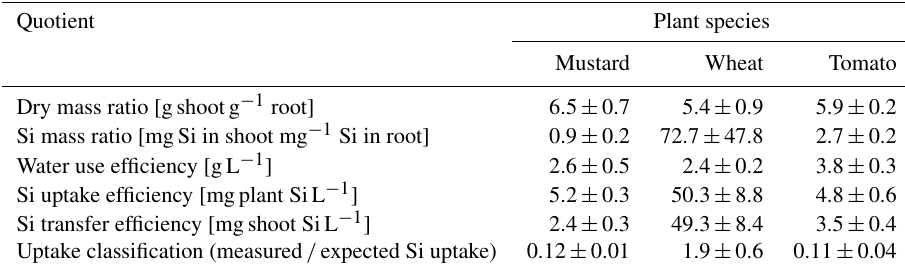
Table 2. Ecophysiological performance ratios for mustard, wheat, and tomato (means ± standard deviation based on three pots with four plants each). The uptake classification is based on the ratio of measured and expected Si uptake. A ratio of greater than 1 indicates an active uptake mechanism, a ratio much smaller than 1 a rejective strategy, and a ratio of 1 passive